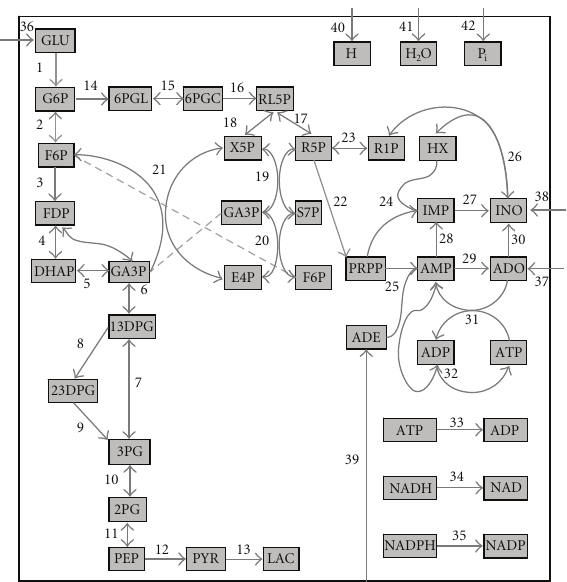
Figure 2: Scheme of the hRBC metabolic network used in our analisys. Squares correspond to metabolites, numbers to reactions (see Table